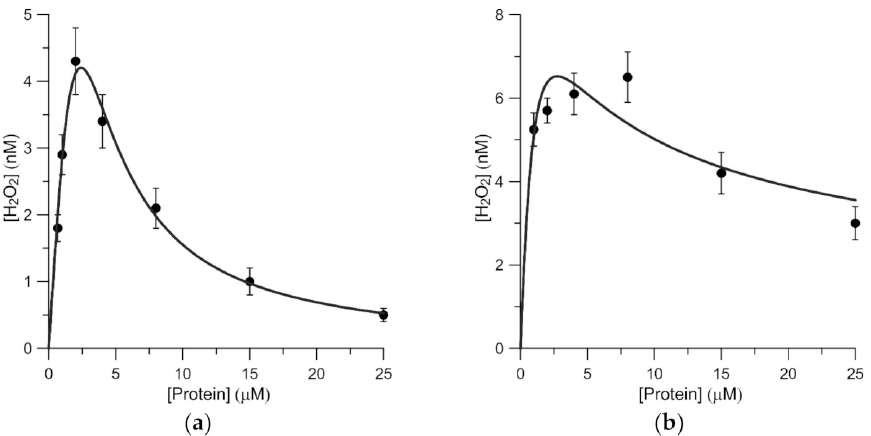
Figure 3. Variation of H 2 O 2 concentration with the protein concentration in aqueous solutions exposed to He–Ne laser radiation (3 mW) for 30 min: ( a ) BGG; ( b ) BSA. The circles are experimentally measured H 2 O 2 concentrations. The solid lines display theoretical approximation of the experimental points by Levenberg–Marquardt